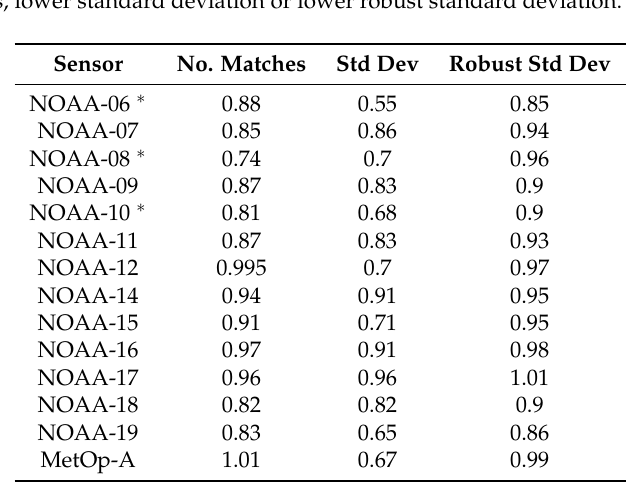
Table 6. Ratio of two-channel (10.8 and 12 µ m) daytime SST retrieval statistics using Bayesian and CLAVR-x cloud masks compared against drifting buoy data. Ratios are calculated using satellite minus in situ SST differences, first applying the Bayesian mask and then comparing against the same statistics with the CLAVR-x mask applied. Values less than one in each column indicate that the Bayesian mask has fewer matches, lower standard deviation or lower robust standard